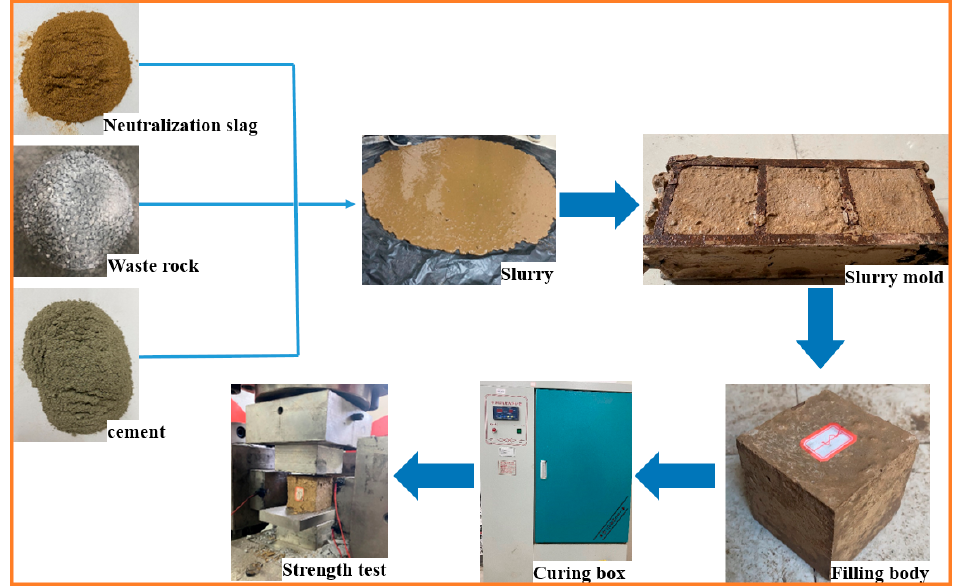
Figure 4. Preparation steps of cemented neutralization slag backfill.